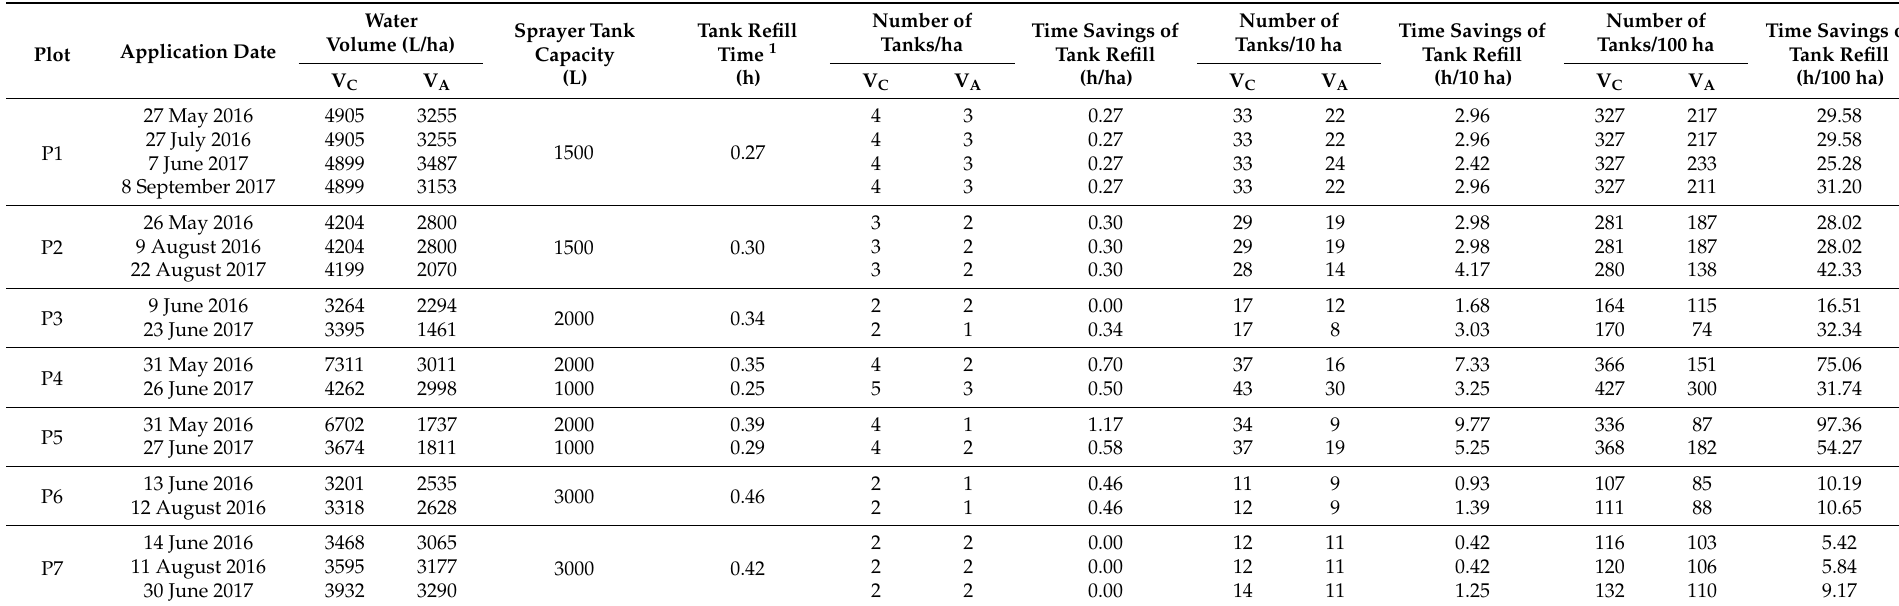
Table 4. Tank refill time for each equipment and orchard, and time savings of tank refill with CitrusVol for each spray application for 1, 10 and 100 hectares.